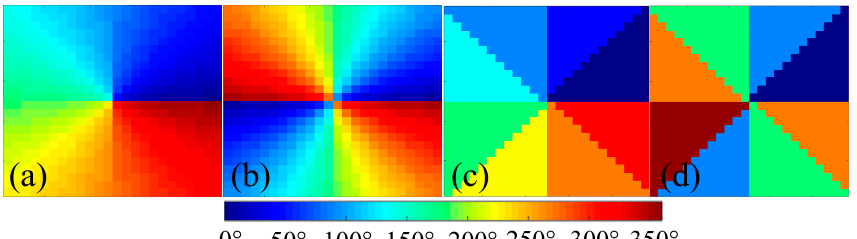
Figure 3. The front view of the continuous vortex phase distribution schemes for generating beams carrying OAM of different orders: ( a ) l = 1. ( b ) l = 2. The discrete vortex phase distribution schemes for generating beams carrying OAM of different orders: ( c ) l = 1. ( d ) l = 2.